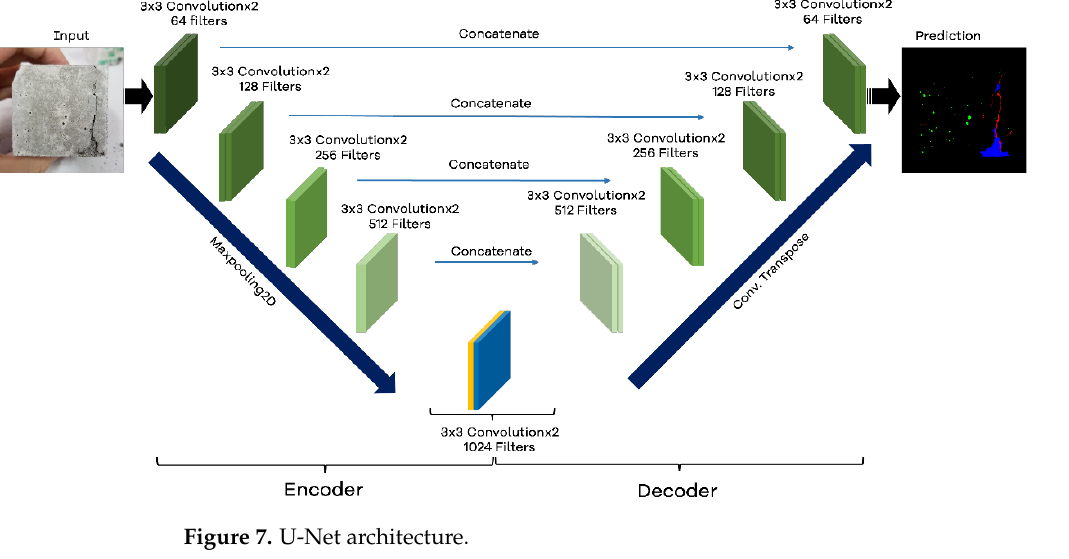
Figure 7. U-Net architecture.